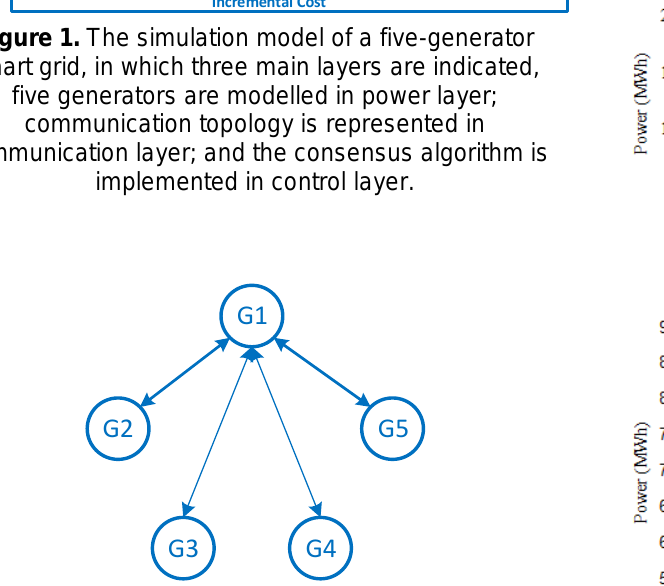
Figure 2. Communication topology of five generators: star topology. Figure 4. Case 1: the power generations and